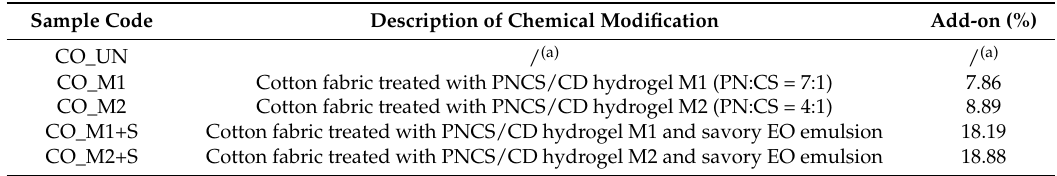
Table 2. Sample codes according to the chemical modification of the functionalized cotton-cellulose fabric and corresponding Add-on